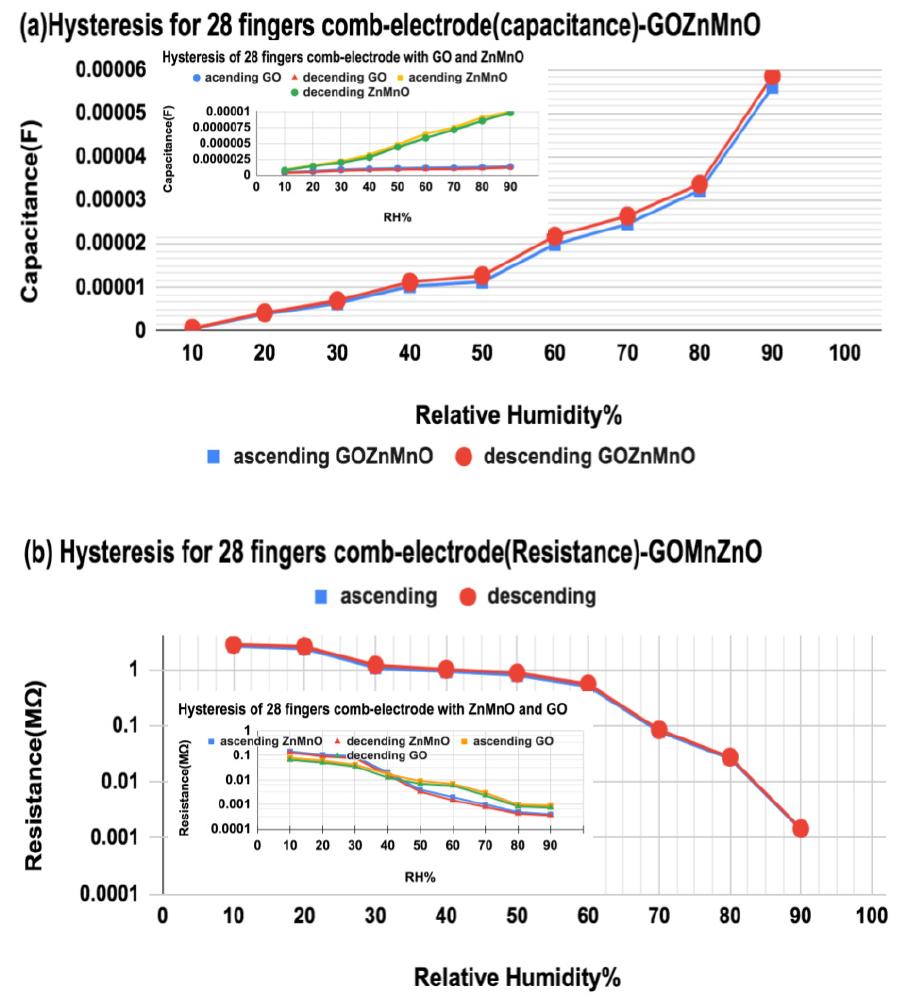
Figure 12. ( a ) Hysteresis error in terms of capacitance for humidification ascending and descending from 10%RH to 90%RH); inset shows the hysteresis error of Mn x Zn 1 − x O and GO. ( b ) Hysteresis error in terms of impedance descending and ascending from 90%RH to 10%RH for GO-Mn x Zn 1 − x O nanohybrid with 28-finger comb electrode; inset shows hysteresis error of Mn x Zn 1 − x O and GO with 28-finger comb electrode.